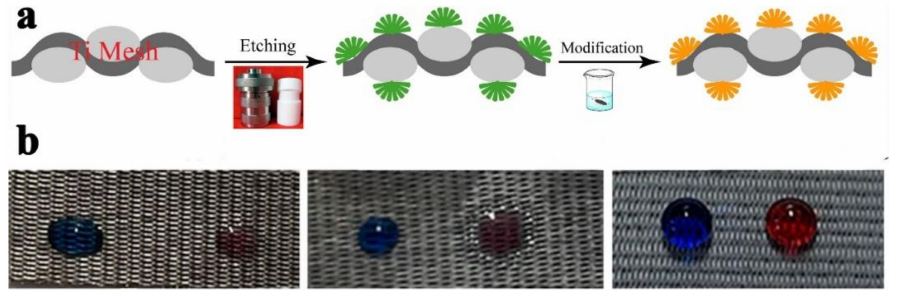
Figure 2. ( a ) Two-step fabrication process. ( b ) Photographs of blue-colored water (72.9 mN/m) and red-colored soybean oil (32.3 mN/m) on the surfaces of the pure unetched mesh ( left ), etched mesh ( center ), and modified mesh ( right